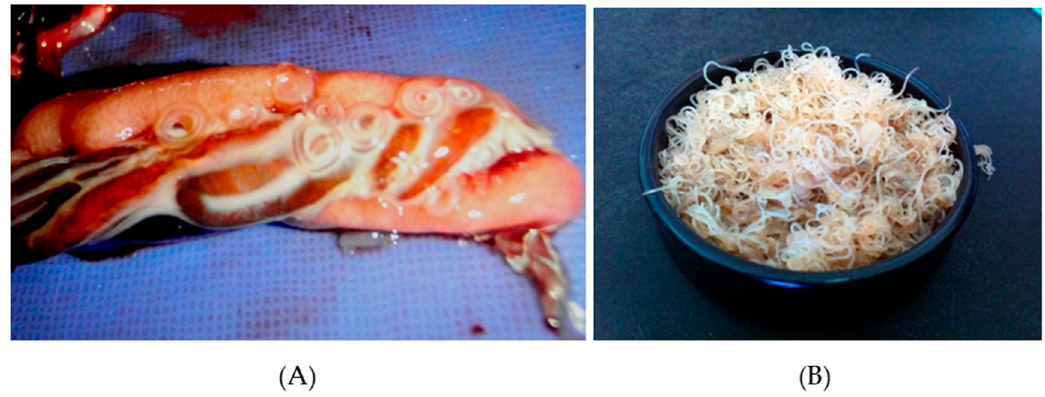
Figure 6. Live third-stage (L3) Anisakis spp. larvae collected from under the visceral serosa of anchovy ( Engraulis encrasicolus ) ( A ) and washed before the experiment ( B ).